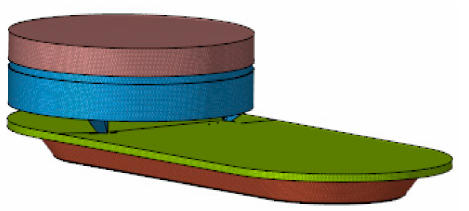
Figure 5. Discretized luminaire Model. Source: our own elaboration from the software